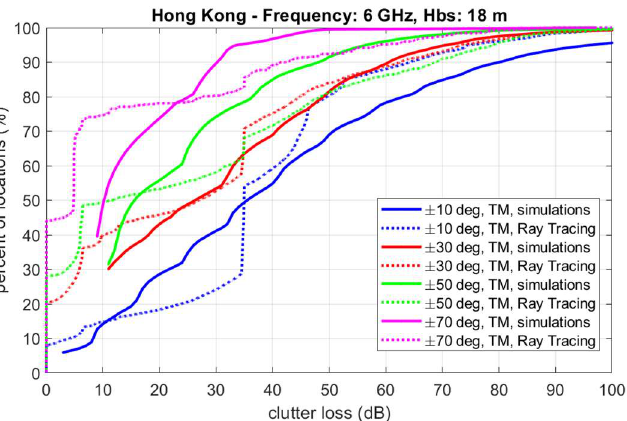
Figure 17. Cumulative distribution function statistics of the clutter loss obtained with the ray tracer tool (dashed line) and with the proposed model, for different elevation angles.